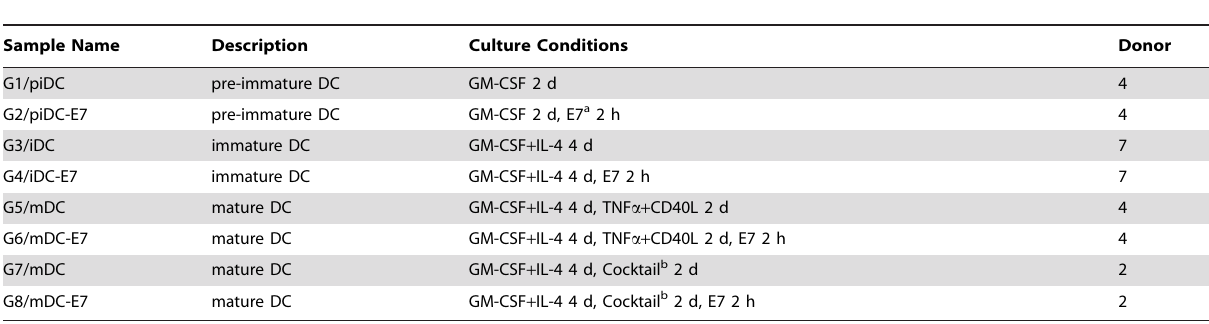
Table 1. RNA sample source and differentiation